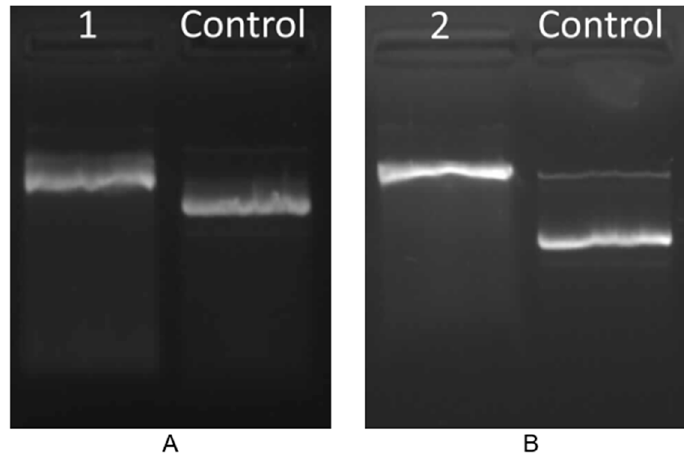
Figure 12. Estimation of DNA damage induced by complex 1 ( A ) and complex 2 ( B ) based on pUC19 plasmid DNA isolated from E. coli DH5 α and digested by Fpg